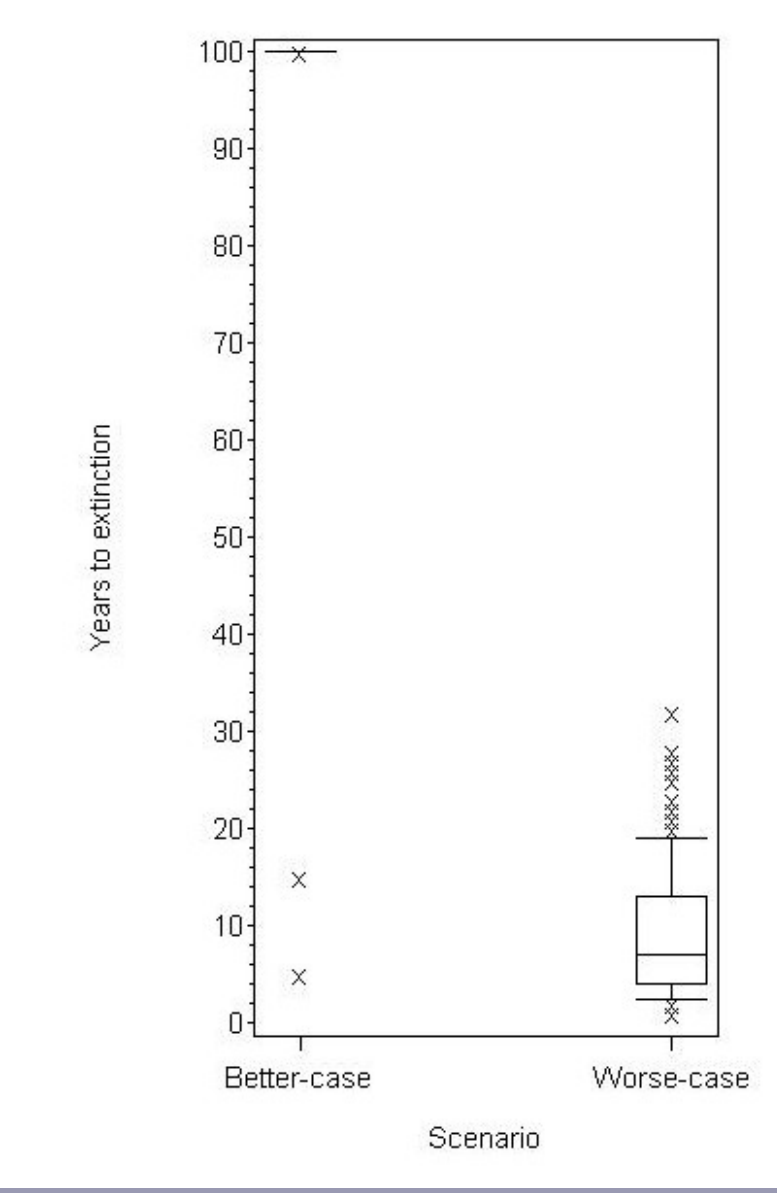
Fig. 4. Years of persistence under two scenarios in a stochastic, stage-based, discrete population model of large-bodied woodpeckers. For the better-case scenario, all input parameters were at their intermediate values, and there was no Allee effect. For the worse-case scenario, initial population size and mean values for annual adult survival and fecundity were held at low values, variances of these demographic rates were held at high values, and there was no Allee effect. The center horizontal line in each box represents the median, edges of boxes represent the interquartile range, whiskers represent the 10th and 90th percentiles, and the symbol x indicates values beyond these percentiles. The 10th–90th percentiles were equal to 100 in the better-case